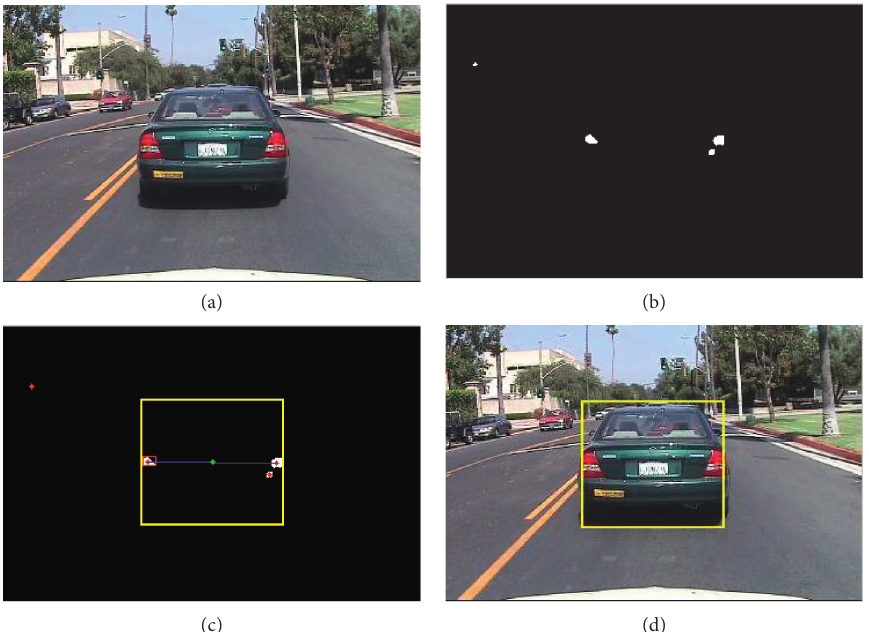
Figure 8: The extraction results of vehicle interest region based on the taillight feature. (a) The original image. (b) Taillight extract result. (c) The interest region extracted by the taillight. (d) Vehicle detection and marking results.